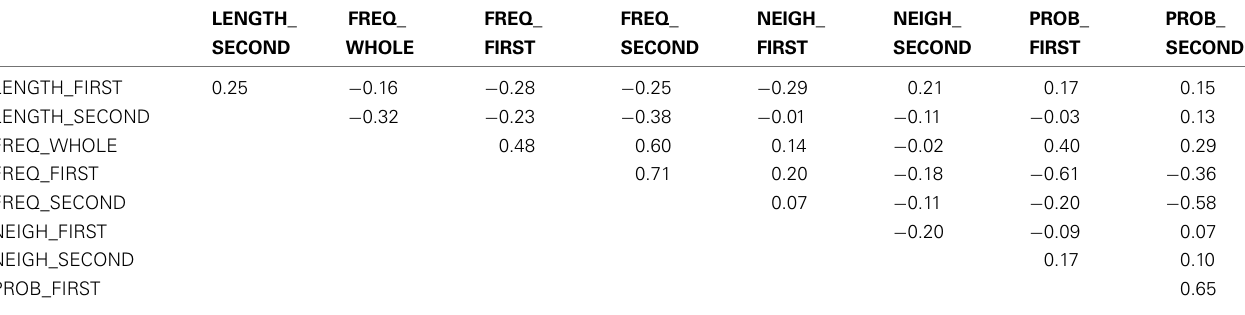
TableA3 | Correlation matrix of predictors used in IB analysis before residualization (values indicate pairwise Pearson correlations).